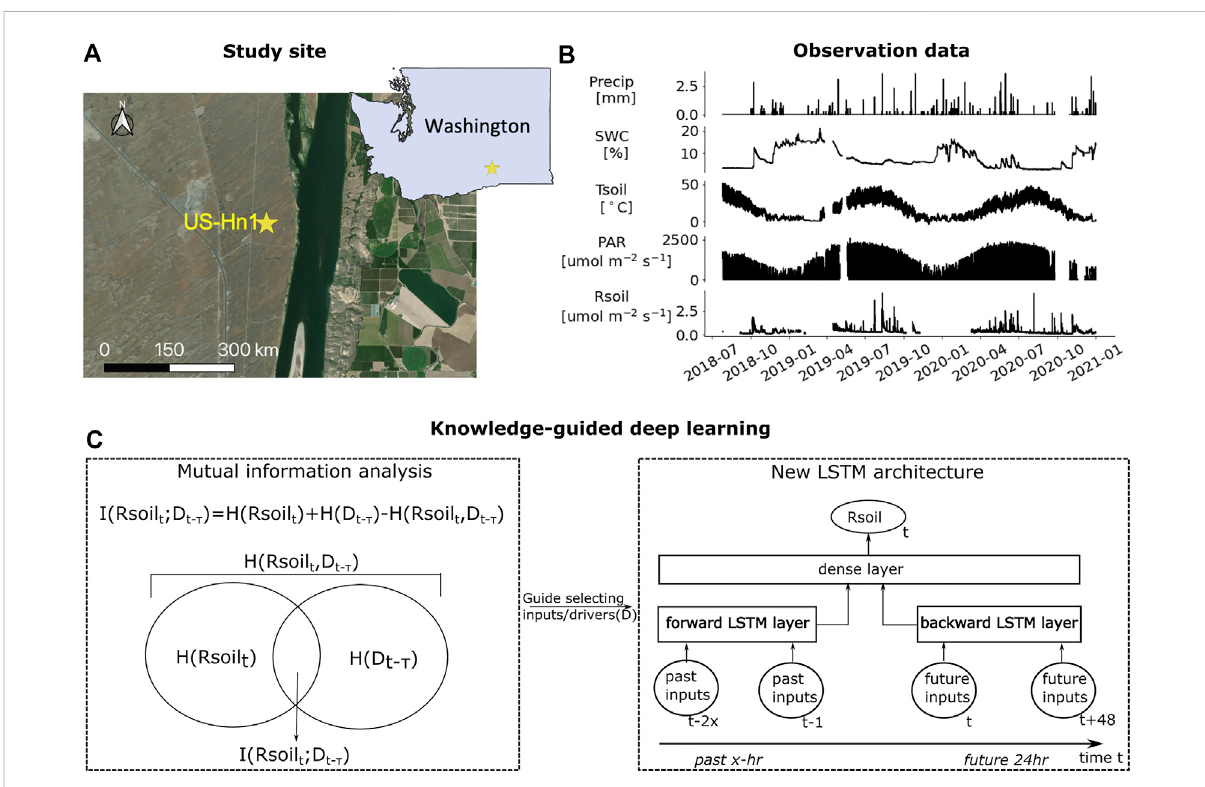
FIGURE 1 Observationsofsoilrespiration(Rsoil)andenvironmentaldriversattheUS-Hn1site. (A) Thegeographiclocationofthestudysite. (B) Timeseries observationsofRsoil,precipitation(Precip),soilwatercontentat5 cmdepth(SWC),soiltemperatureat5 cmdepth(Tsoil),andphotosyntheticactive radiation (PAR) ata temporal resolution of30-min. (C) The new LSTM architecturewhose past and future inputs are informed bymutual information